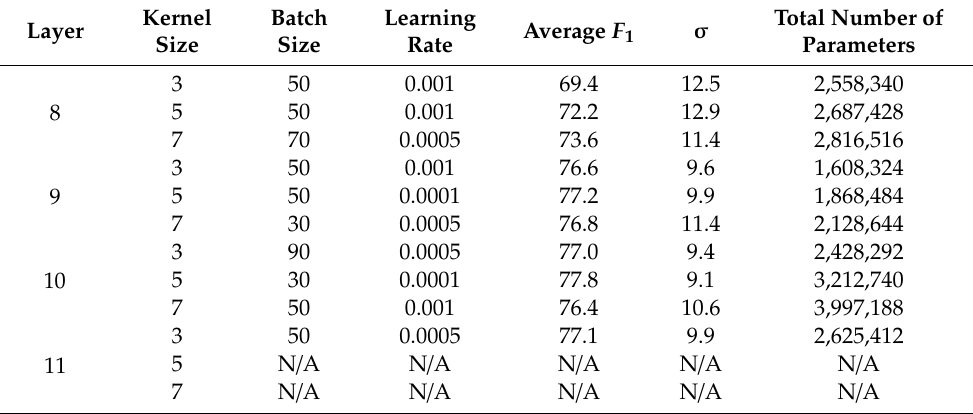
Table 5. The best average F 1 under various combinations of hyperparameters.